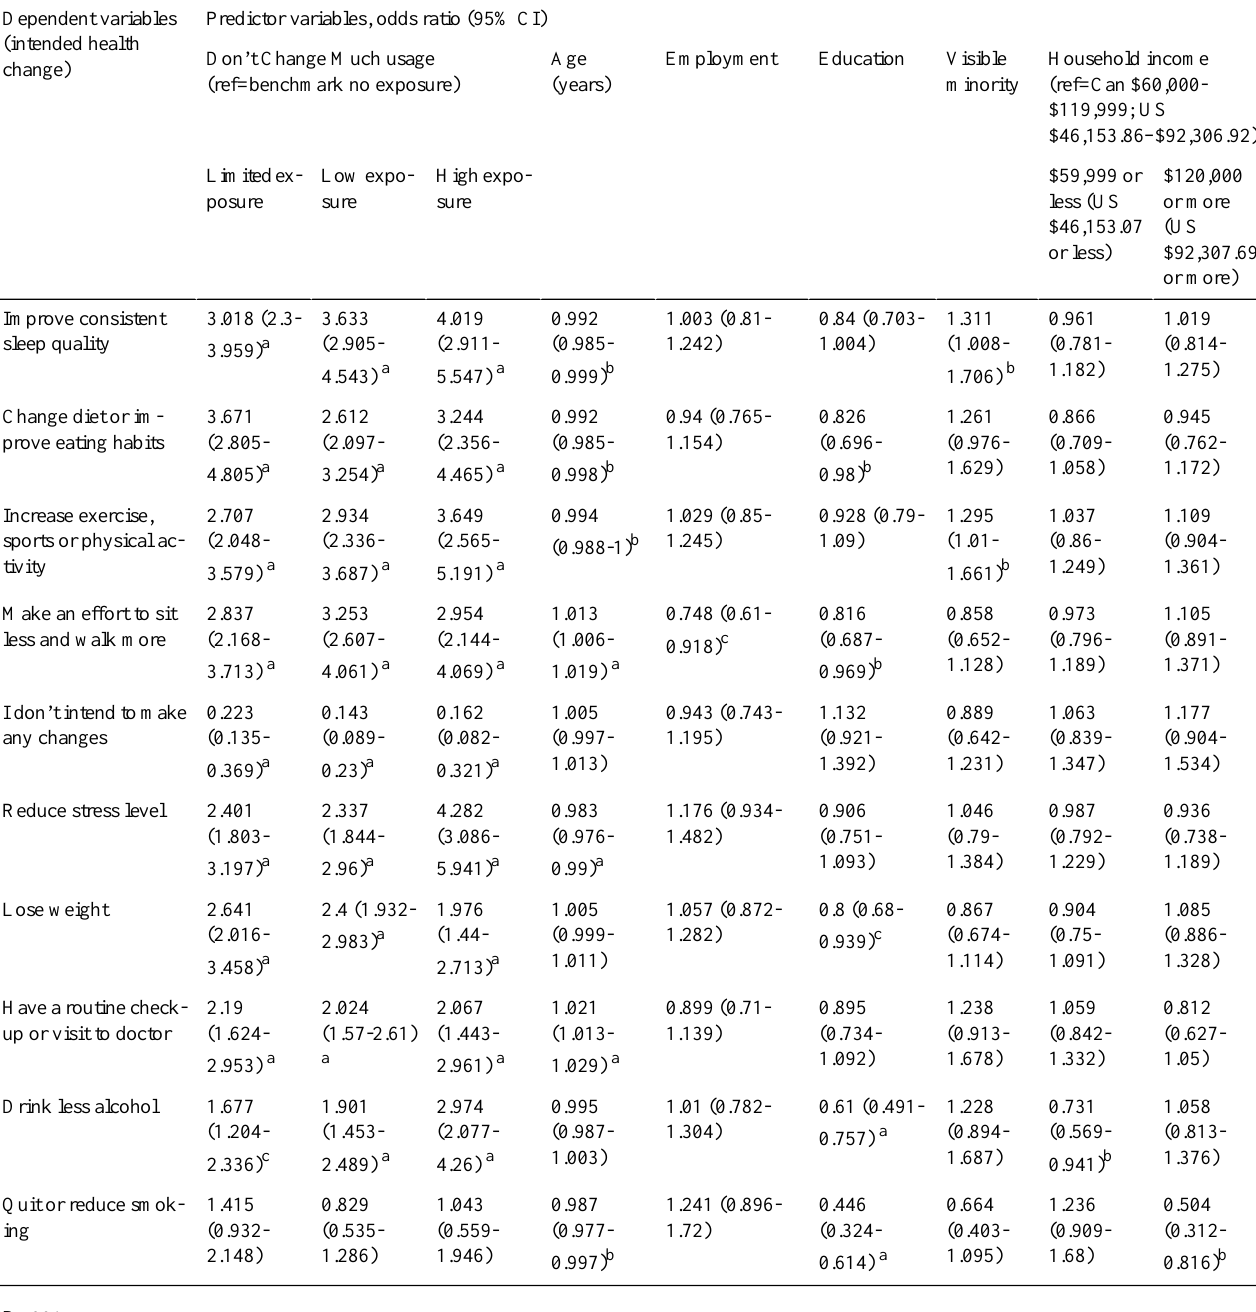
Table 3. Logistic regressions between statistically significant demographics and intended health changes (separate multiple logistic regressions were conducted for each outcome variable with all predictor variables entered on the same